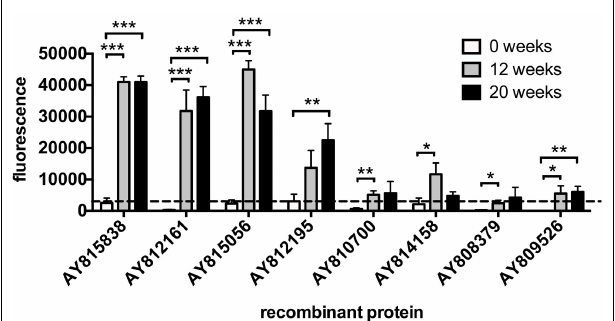
FIGURE 6 | IgG antibody profiles to arrayed antigens differ in Schistosoma japonicum -infected, self-curing rhesus macaques during the course of infection from exposure to perfusion . Average adjusted signal intensity values depicting IgG antibody responses to each significantly reactive antigen are shown at baseline (0weeks), 12weeks post-infection, and elimination (20weeks post-infection). The dashed line is the cut-off for IgG reactivity (3210), calculated as one standard deviation of the mean of the no-DNA control spots on the array. Statistical analysis was performed using Student’s t -test. * p < 0.05, ** p < 0.01, *** p < 0.001.